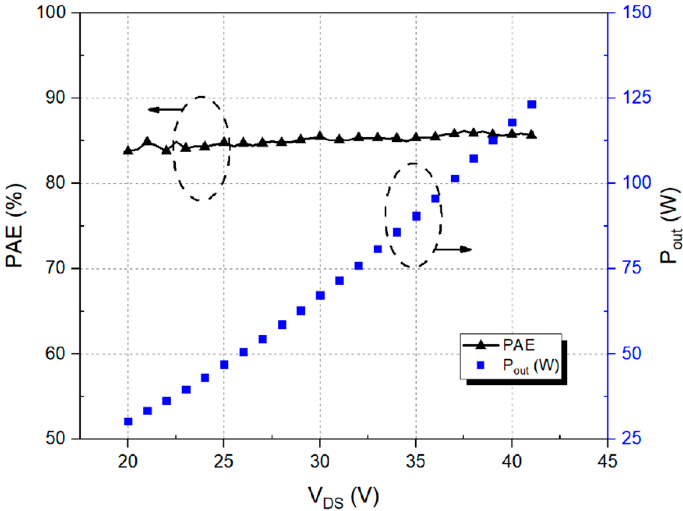
Figure 13. Measured results of the proposed power module after operation for a period of one hour.